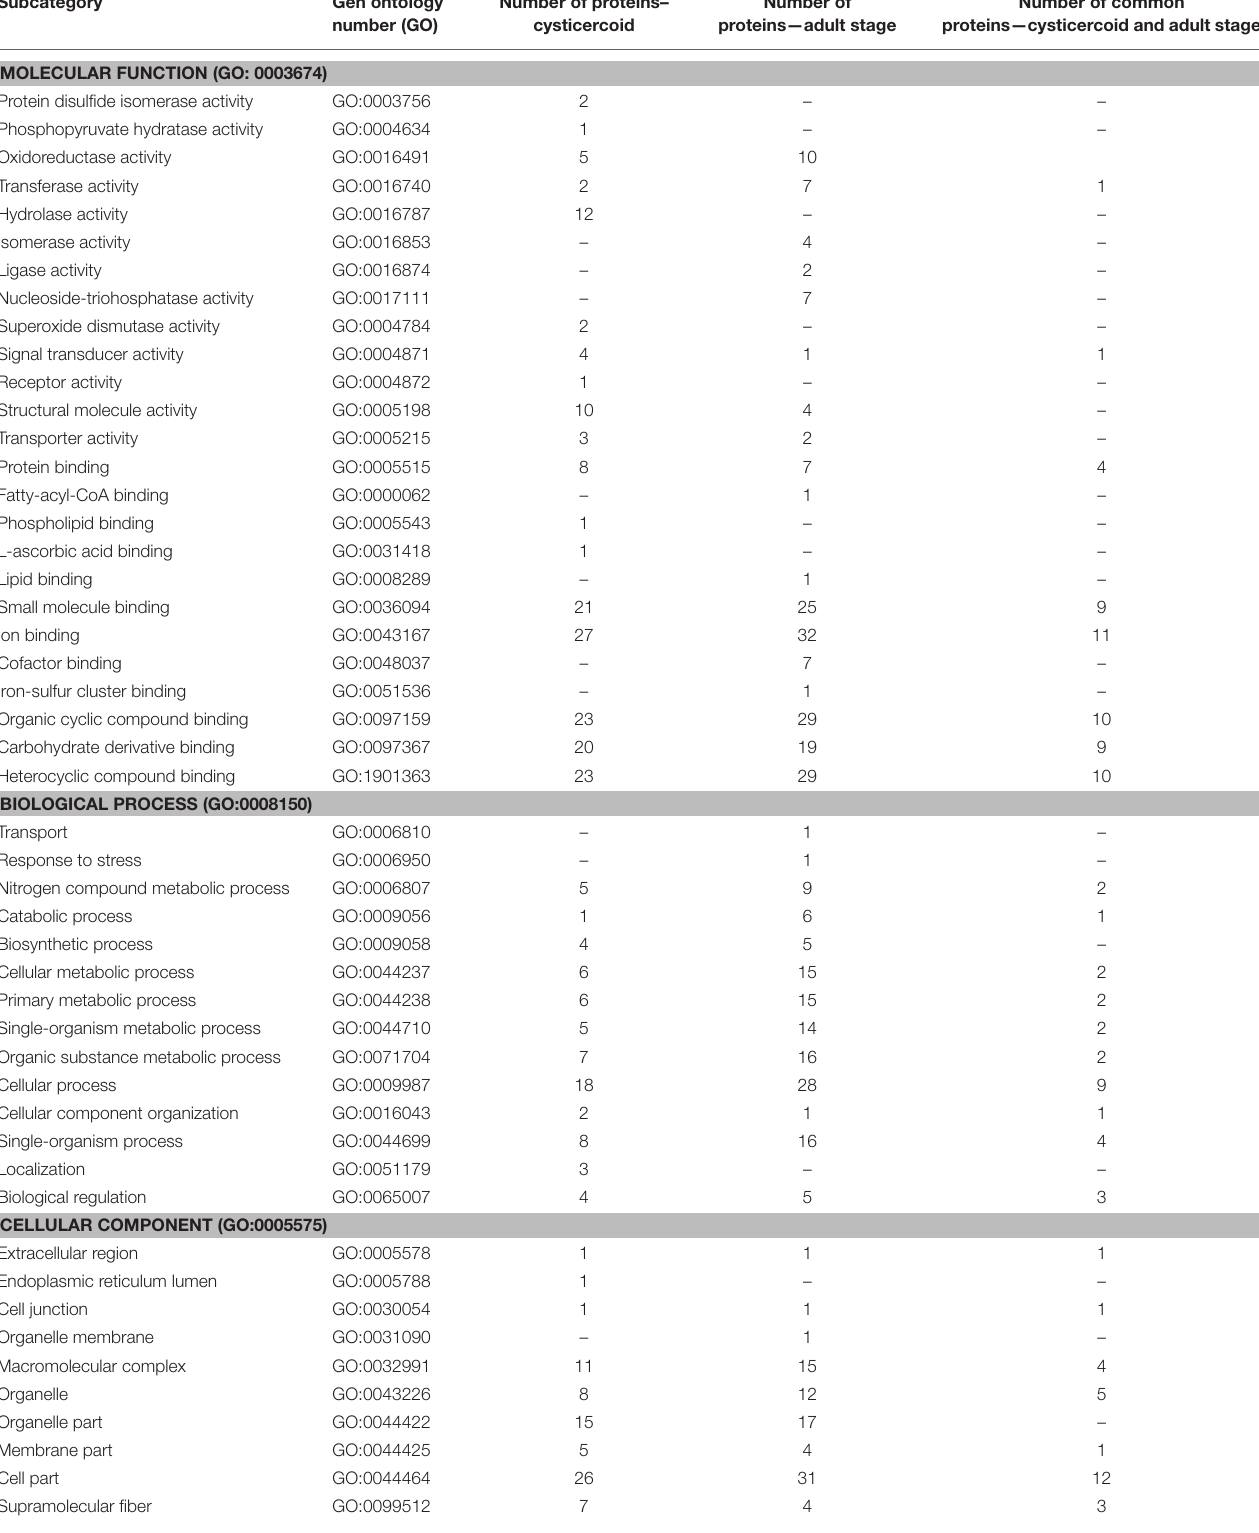
TABLE 3 | Functions of H. diminuta cysticercoid and adult stage proteins according to theirGene Ontology (GO) category for samples identified using in-solution digestion. Subcategory Gen ontology